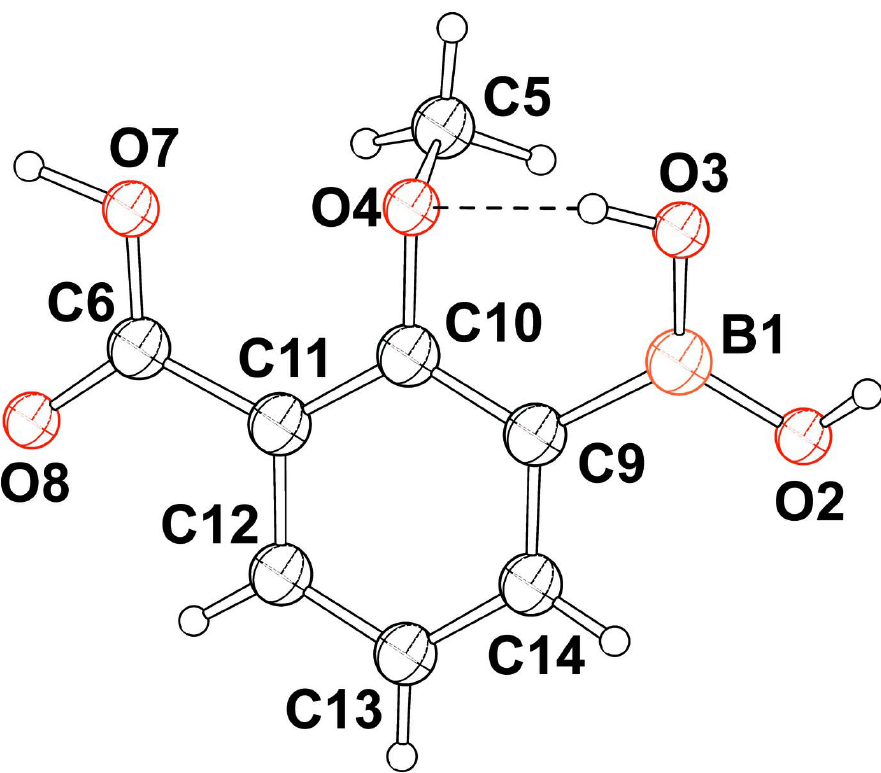
Figure 1 The molecular structure of (I) showing the atom-labelling scheme. The intramolecular hydrogen bond is shown as a dashed lines. Displacement ellipsoids for all non-H atoms are drawn at the 50% probability level.